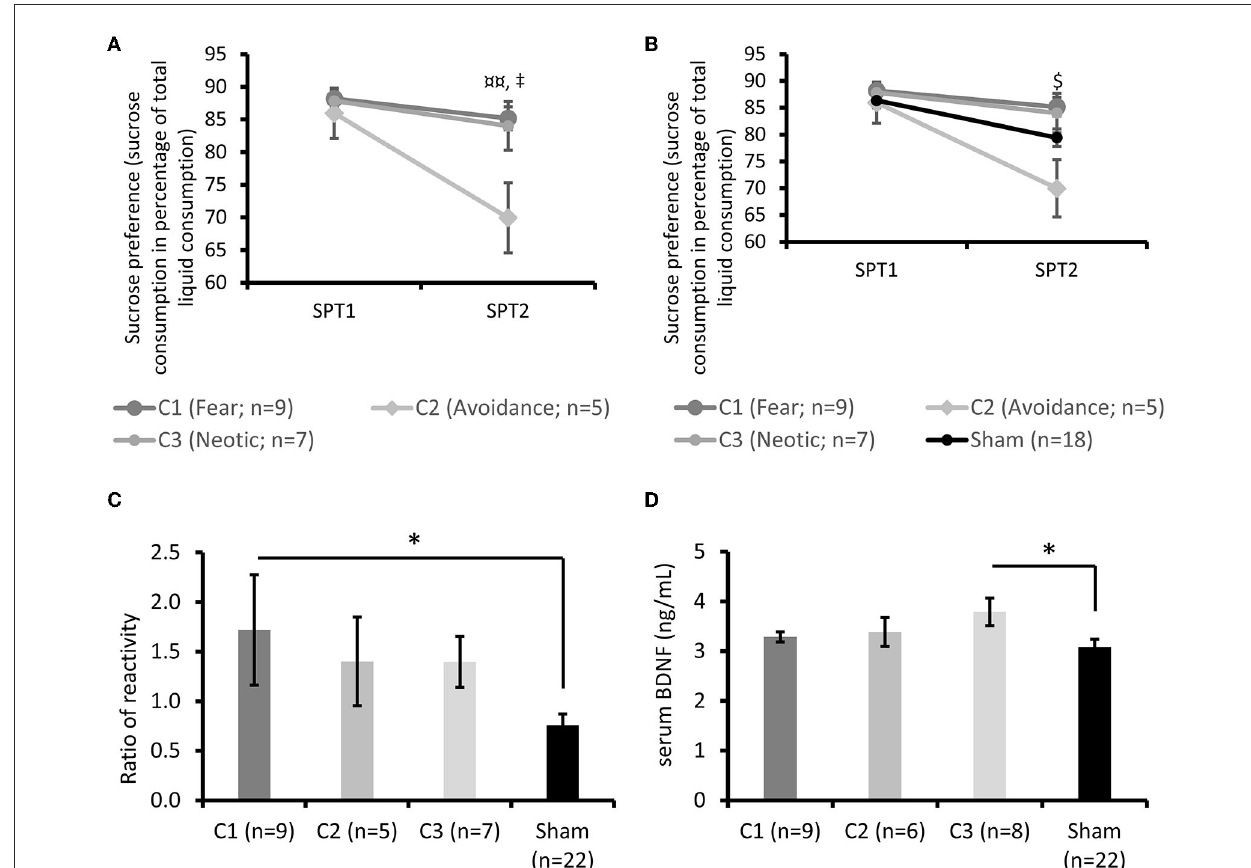
FIGURE6 Behavioral and biological subgroup characterization. (A) Sucrose preference tests before and after stress exposure. Post-hoc test ¤¤ p < 0.01 between the C1 (Fear) and C2 (Avoidance) subgroups, ‡ p < 0.05 between the C2 and C3 (Neotic) subgroups. (B) Sucrose preference tests before and after stress exposure. $ p < 0.05 between the C2 subgroup and the Sham group. (C) Startle reactivity compared to the Sham group. Post-hoc test * p < 0.05. (D) sBDNF at death compared to the Sham group. Post-hoc test * p < 0.05. Results are expressed as mean ±